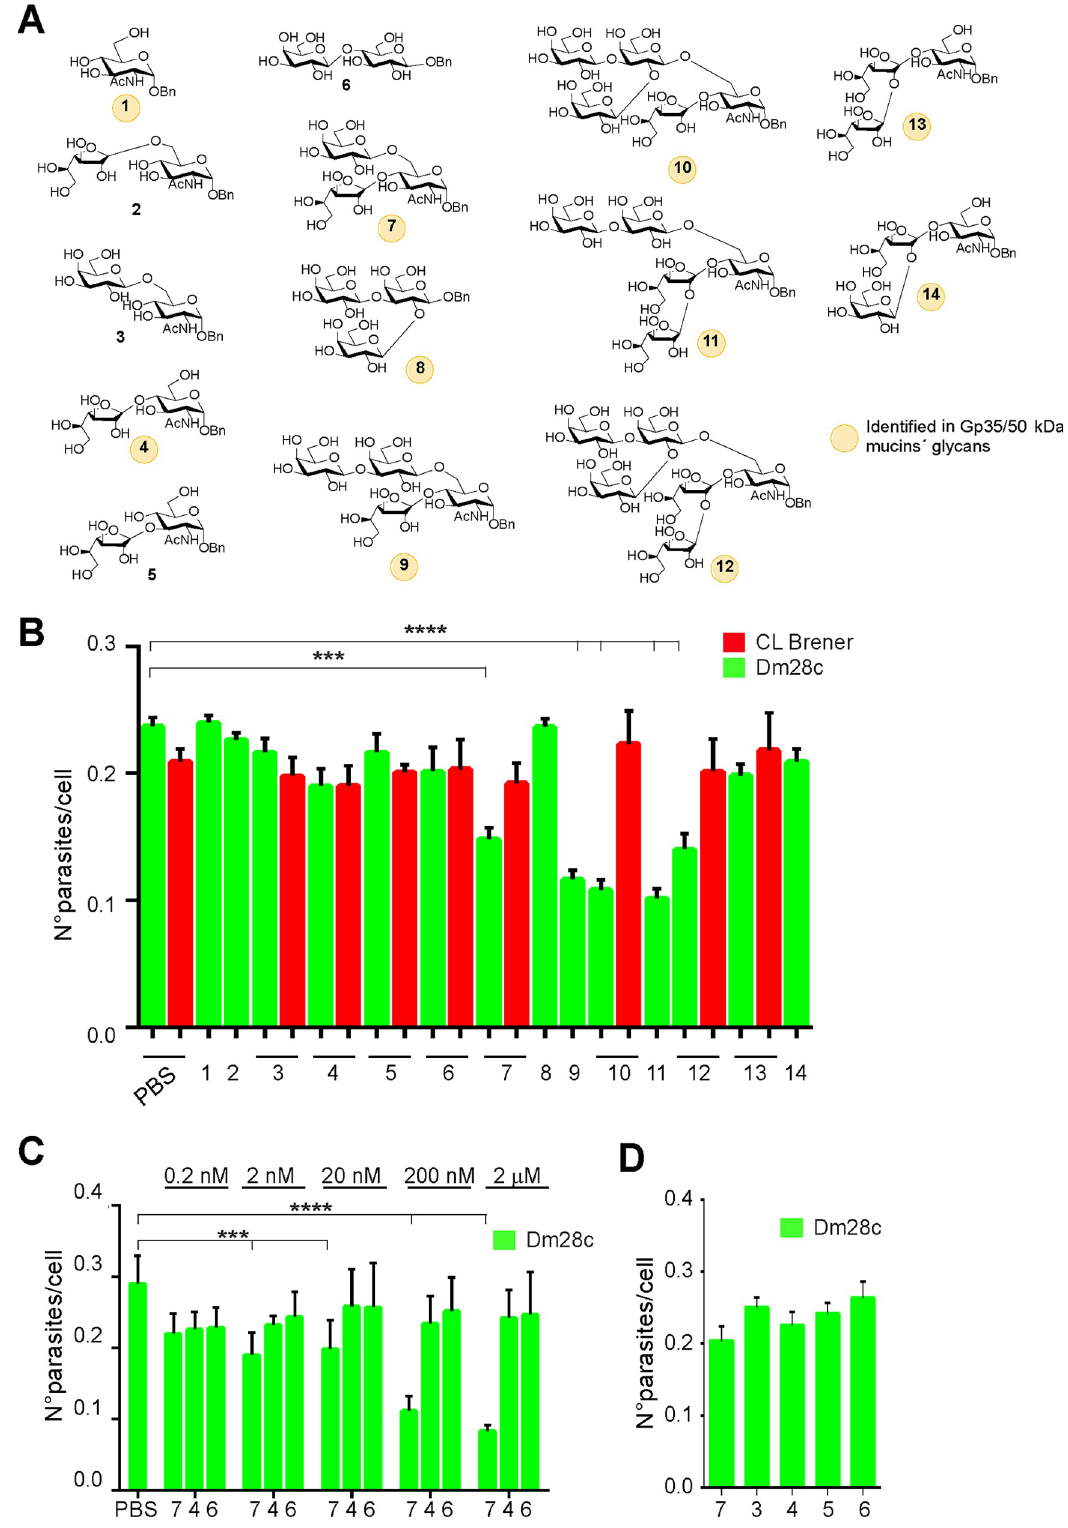
Fig 4. O -linked oligosaccharides mediate adhesion of Gp35/50 kDa mucins to T . infestans rectal ampoule. A) Schematic representation of the structures of the oligosaccharides synthesized and assayed in this work. B) Hindguts obtained from